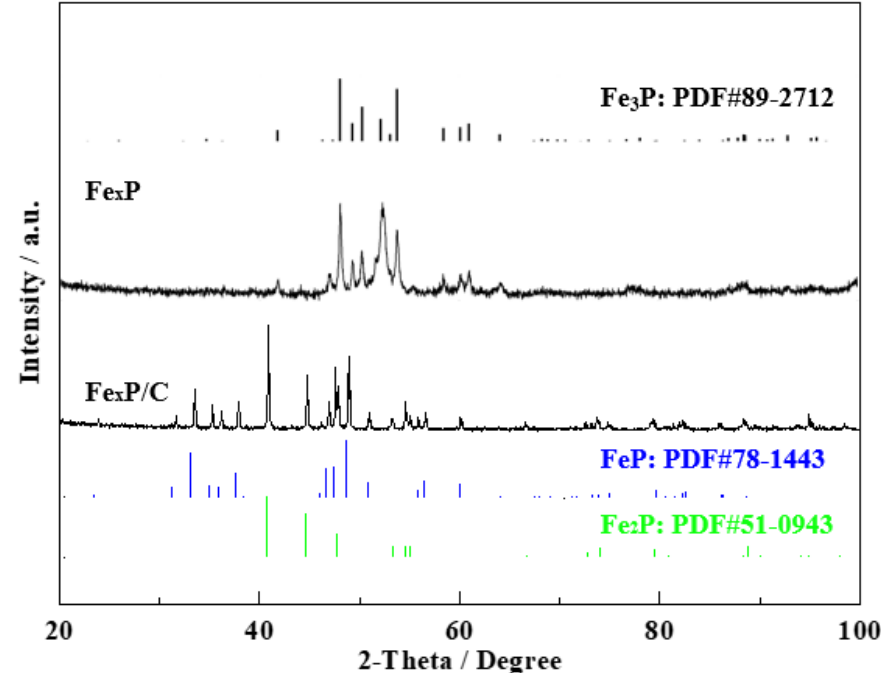
Figure 2. XRD pattern of Fe x P and Fe x P/C .